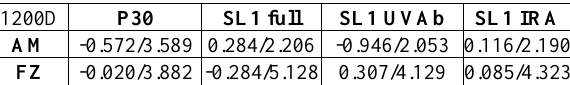
Table 14: geometric comparisons for OBJ3 (mean/RMS distances in mm)